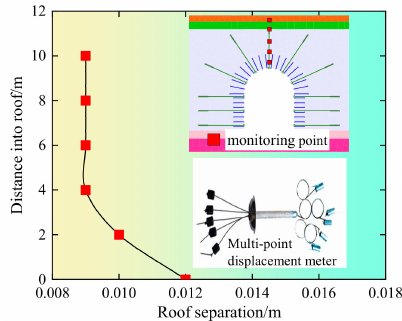
Figure 19. Deformation of the chamber surrounding